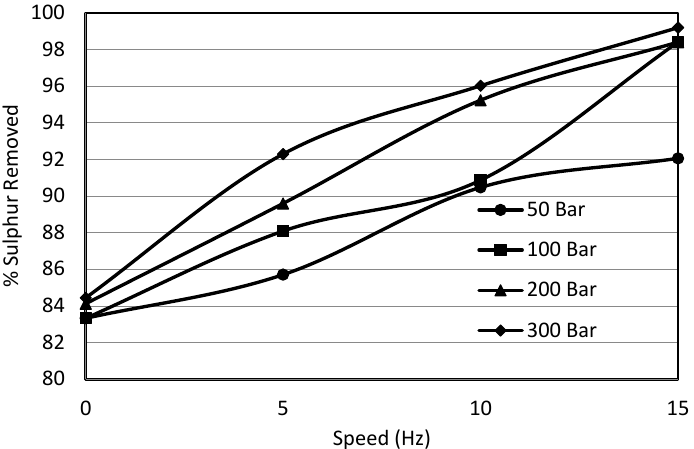
Figure 6. Effect of Impeller Speed on pyritic sulphur removal.